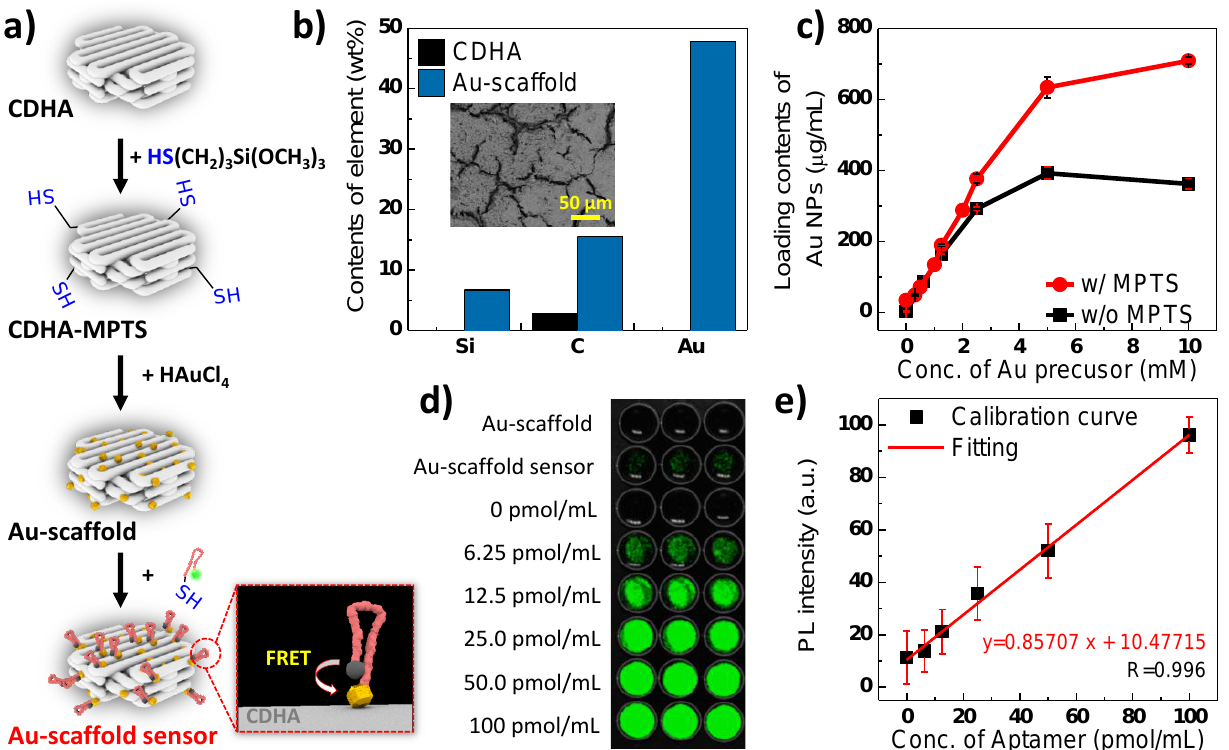
Figure 1. Synthesis and characterization of Au-scaffold sensor. ( a ) Schematic illustration of the synthesis of Au-scaffold sensor. ( b ) EDS analysis from the inset SEM image of Au-scaffold. ( c ) Quantitative analysis of Au NPs on the Au-scaffold by ICP analysis. ( d ) Fluorescence imaging for quantifying the amount of probe DNA on the Au-scaffold sensor. ( e ) Calibration curve for quantification of Probe DNA.